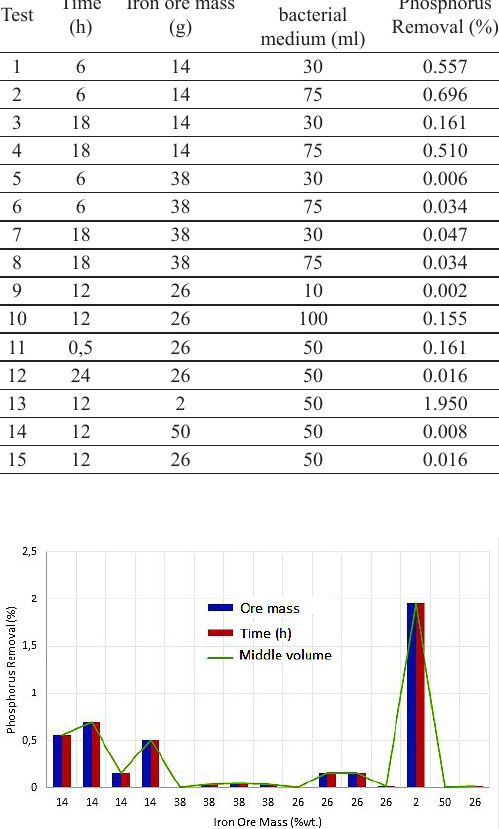
Figure 3. Results of the phosphorus removal tests using the burkolderia caribensis strain.